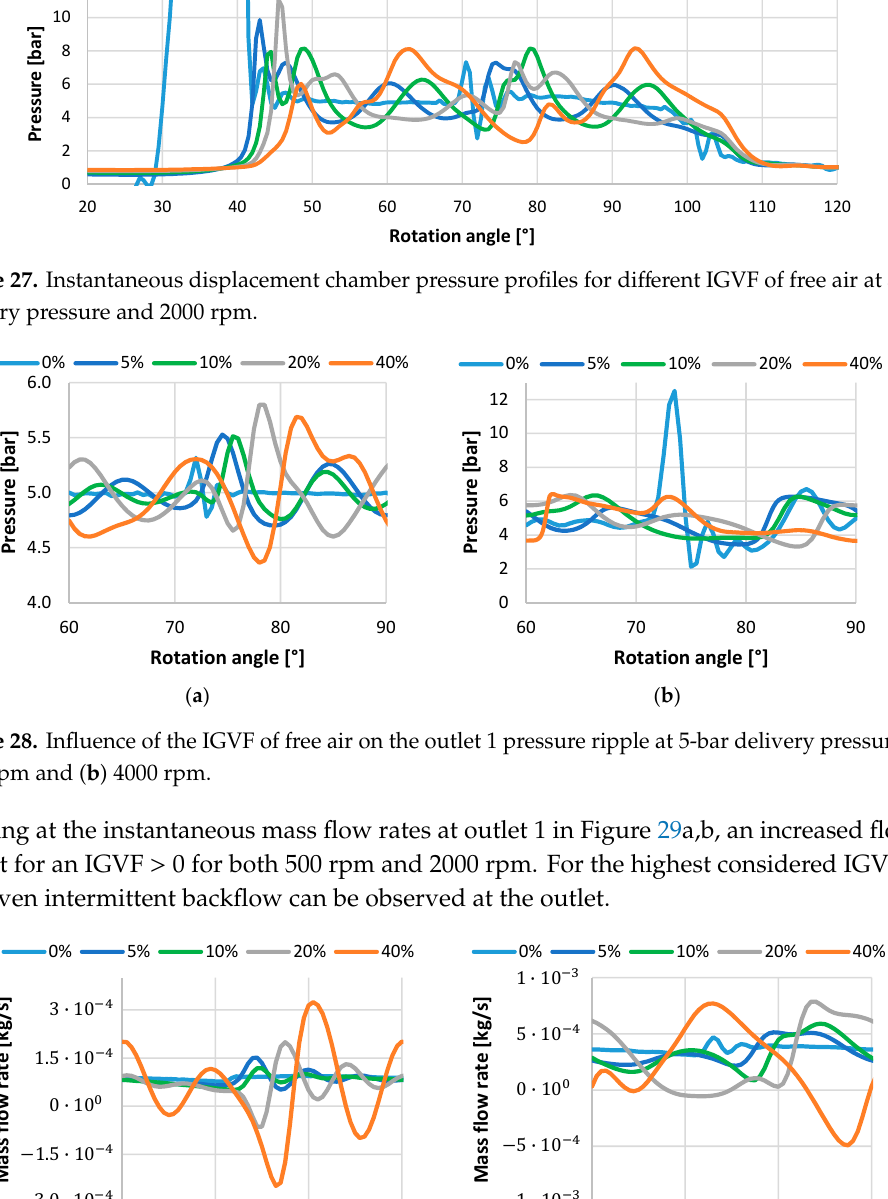
Figure 28. Influence of the IGVF of free air on the outlet 1 pressure ripple at 5-bar delivery pressure, ( a ) 1000 rpm and ( b ) 4000 rpm.